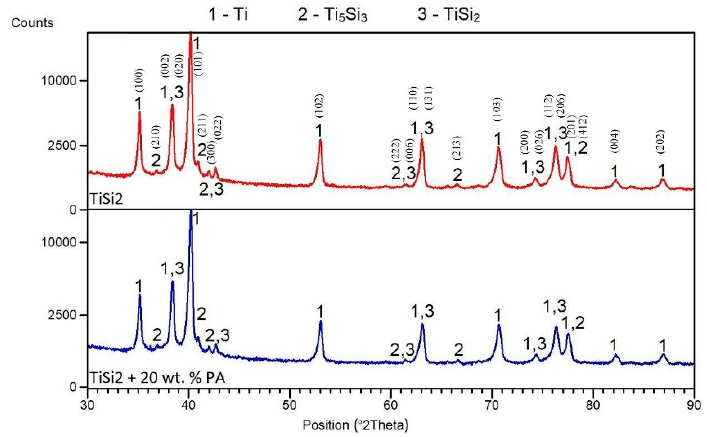
Figure 4. XRD patterns of TiSi2 and TiSi2 + 20 wt.% PA alloys.